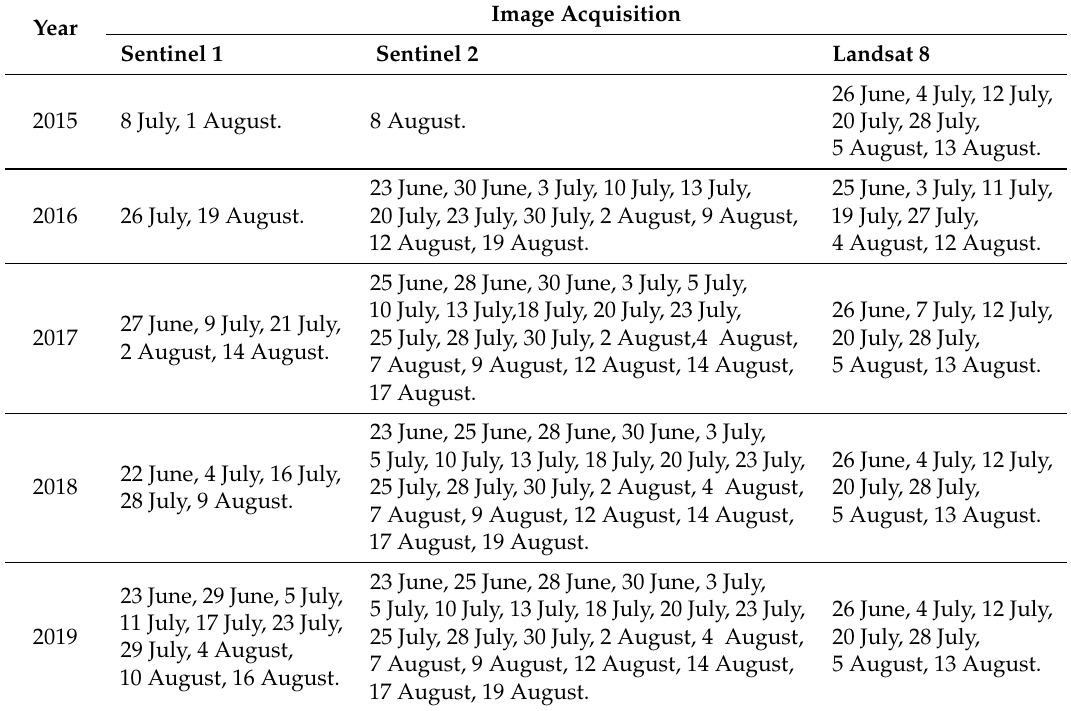
Table 2. Details of images used in this